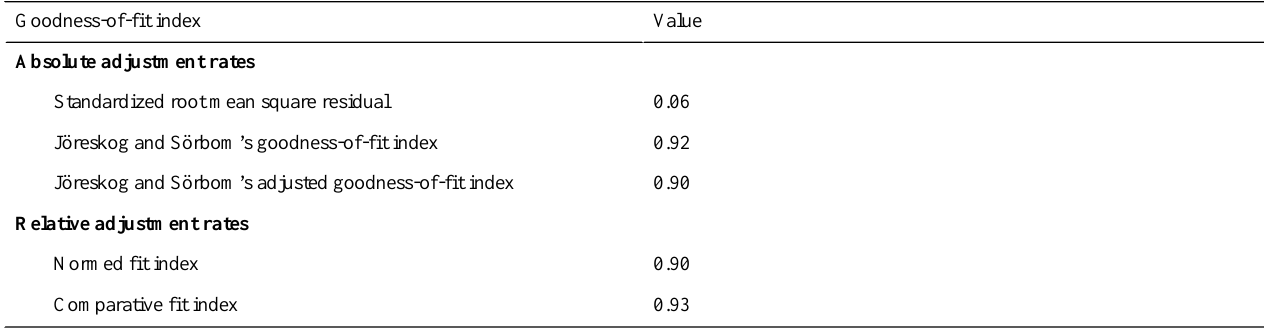
Table 1. Confirmatory factor analysis to determine fit to the data.